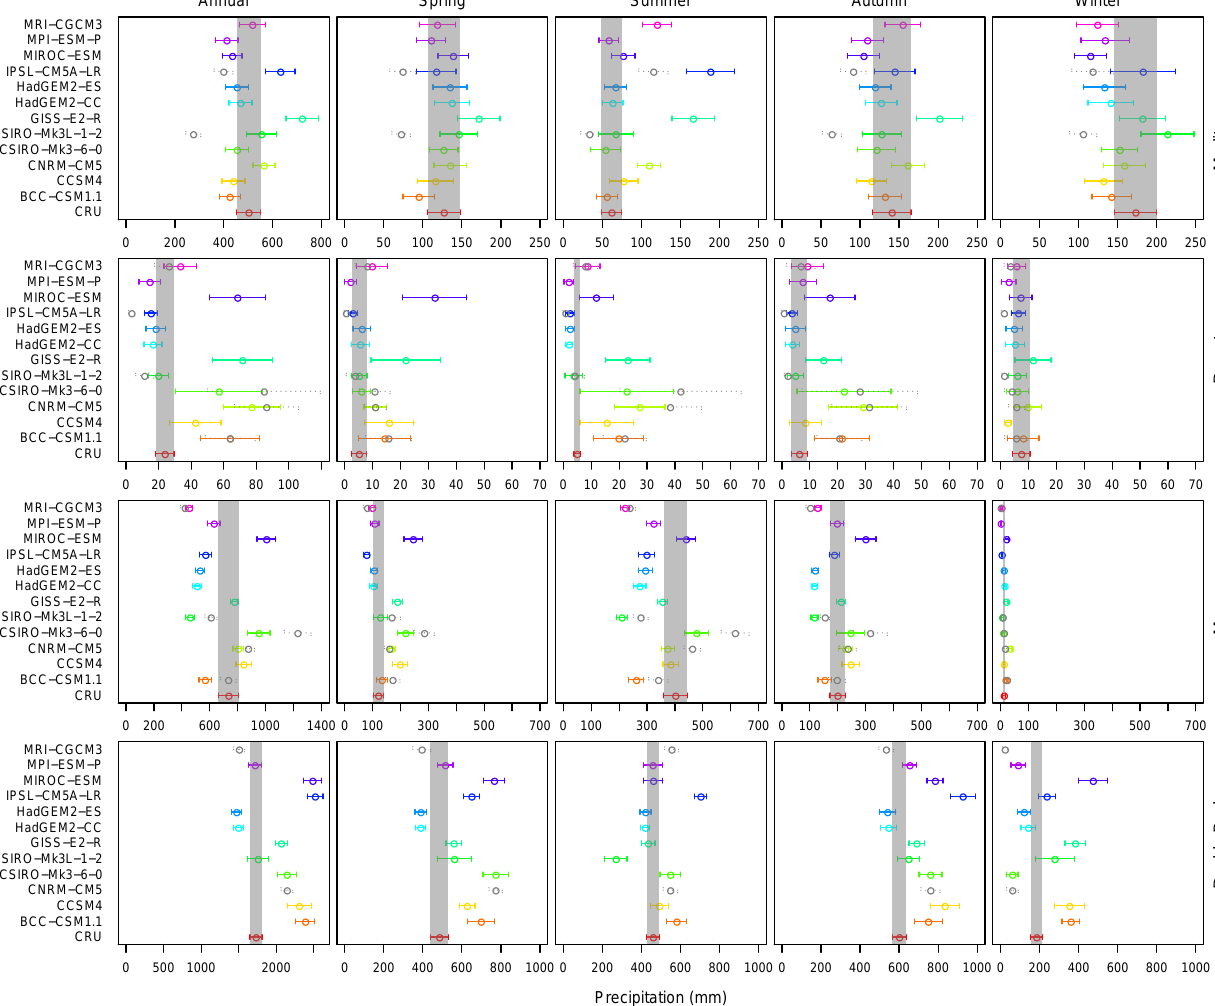
Fig. 4. Comparison of simulated and observed mean annual and mean seasonal precipitation (mm) for each of the defined precipitation regimes (Mediterranean, desert, monsoon, double peak). The simulated precipitation (mean and standard deviation) is shown for both the climate zone as defined by the observations (solid line) and as defined in the piControl simulation itself (dotted line). The difference between these two lines for each model provides a measure of the degree to which incorrect placement of a given climate affects the zonal means. The grey bars represent one standard deviation of the mean annual and mean seasonal precipitation from observations. The seasons are defined as spring, summer, autumn and winter (as in Sect.